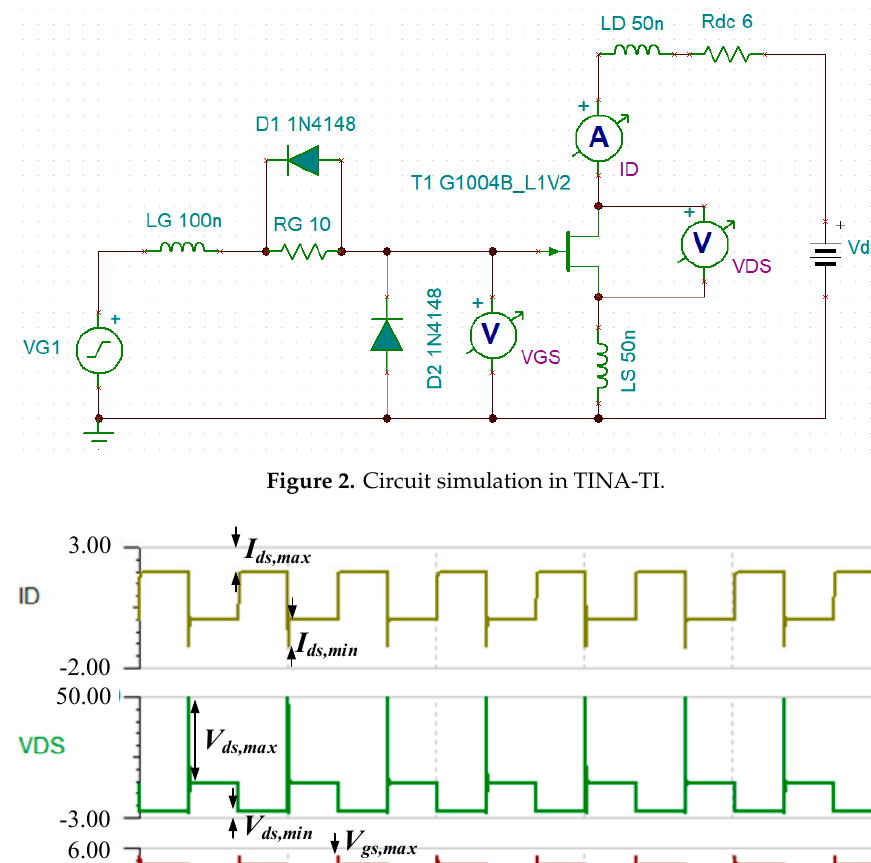
Figure 3. Simulation of waveform changes in I ds , V ds , and V gs when di / dt and dv / dt